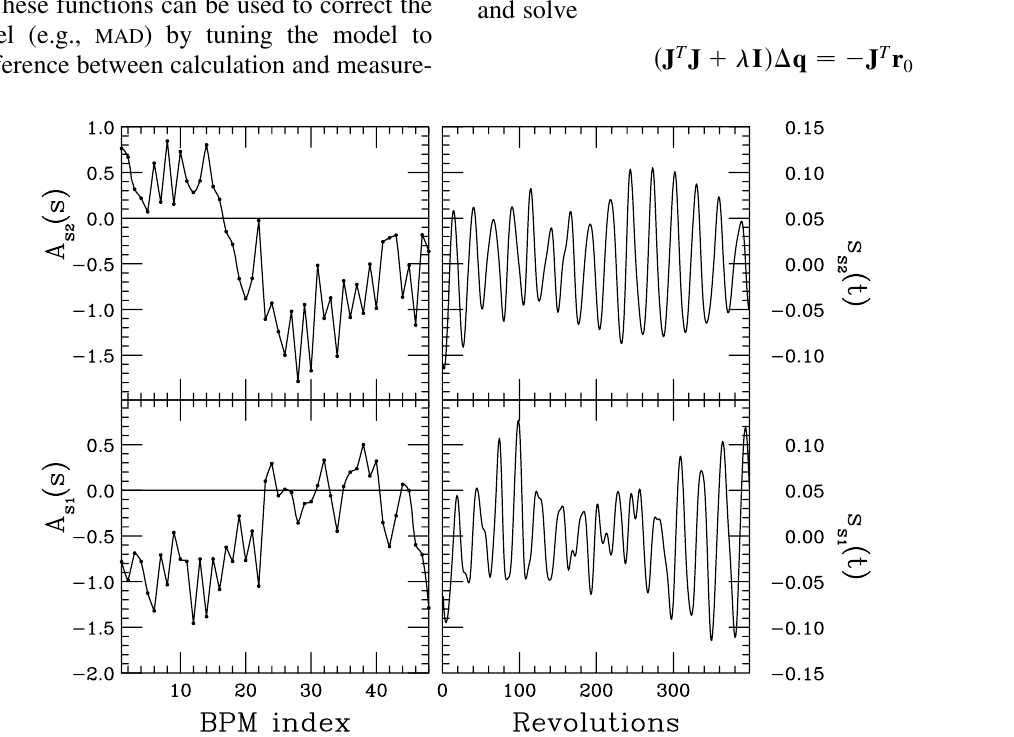
FIG. 13. Synchrotron modes in the middle of a booster cycle. The turn range is 3001 to 3400 (see Fig. 12). The temporal signals provide us the synchrotron tune shown in Fig. 11. The spatial pattern does not resemble the dispersion function. Furthermore, the spatial function crosses zero. The effective amplitude of the off-momentum coordinate is about 10 (cid:15) 5 . This may result from the longitudinal damper or mismatch between the beam energy and the main dipole